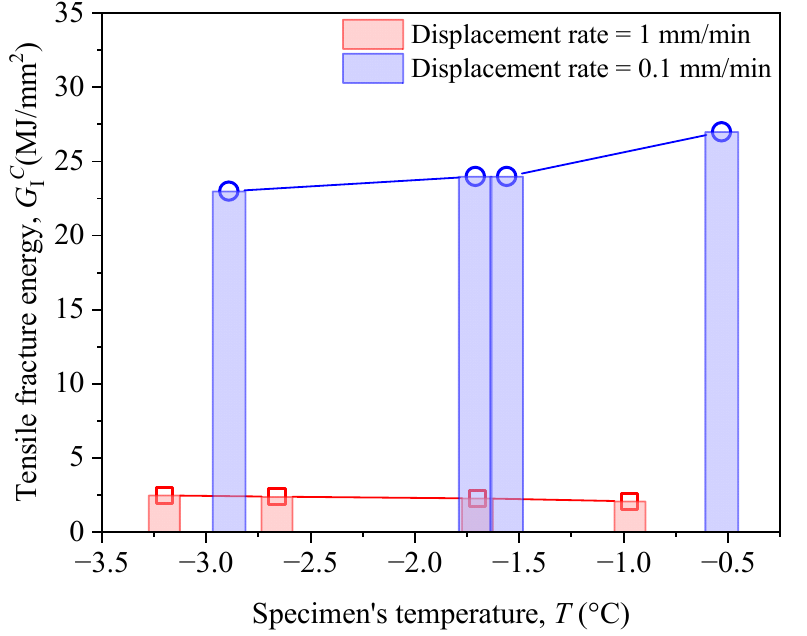
C G and the specimen’s temperature. Figure 11. The relationship between the fracture energy G C I and the specimen’s I